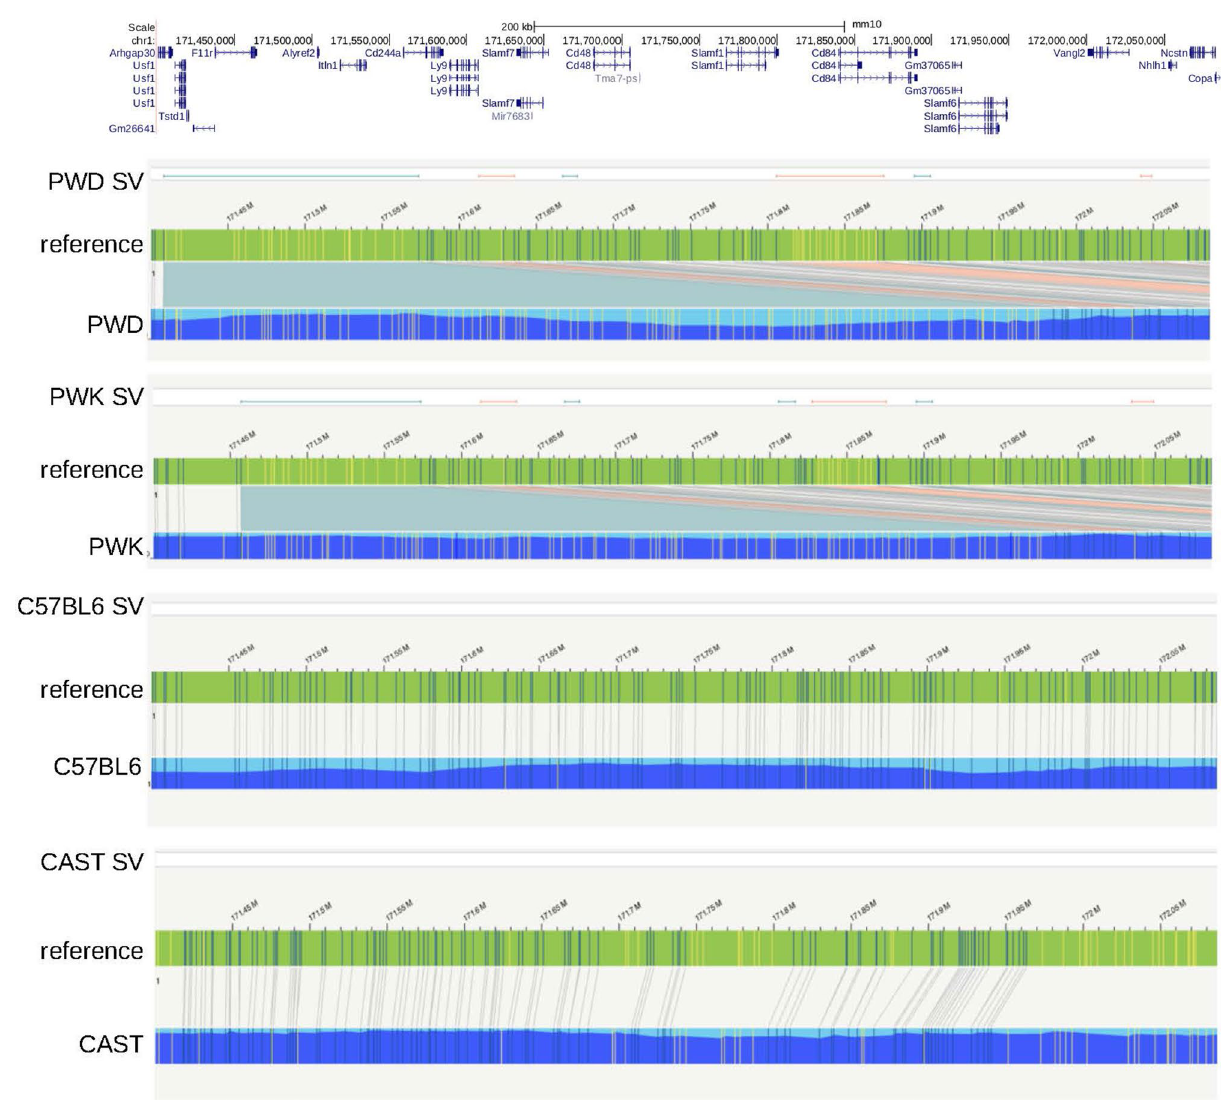
Figure 5. Optical mapping of the intelectin region in laboratory strain mice. Optical mapping results from four strains (PWD, PWK, C57BL/6NCrl, CAST/EiJ) have been aligned against the reference genome (green bar, reference assembly, blue bar new strain assembly with depth of coverage indicated by the dark blue). The yellow and blue vertical lines in these bars represent NtBspQI restriction enzyme cutting sites or DLE-1 binding sites (CTT AAG motif). A blue vertical line indicates sites that are matching between the new assembly and the reference genome, yellow indicates that the site is there in the reference or the new assembly, but are considered non-matching. Regions showing structural variation, with respect to the C57BL6/J reference genome, are annotated as SV, green lines showing putative insertions and red lines showing putative deletions. An extra ~ 400 kb of sequence is in both PWK and PWD strains in the Itln1 region, consistent with the presence of the full complement of intelectin genes. Gene annotations are at the top and are taken from the UCSC Genome